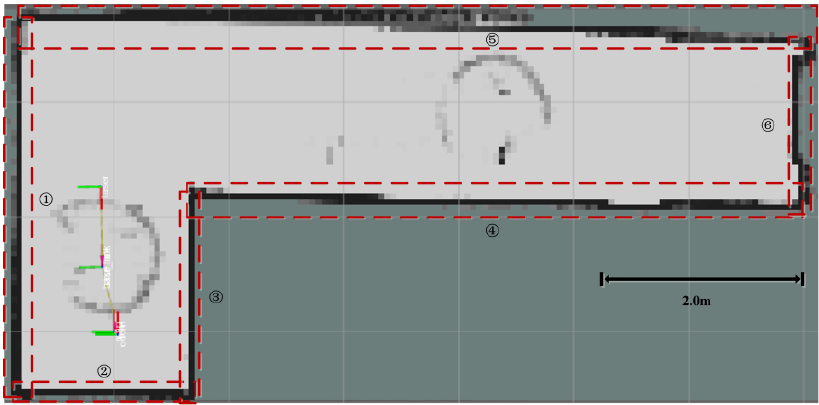
Figure 19. The environment map constructed by the robot in the fire environment.